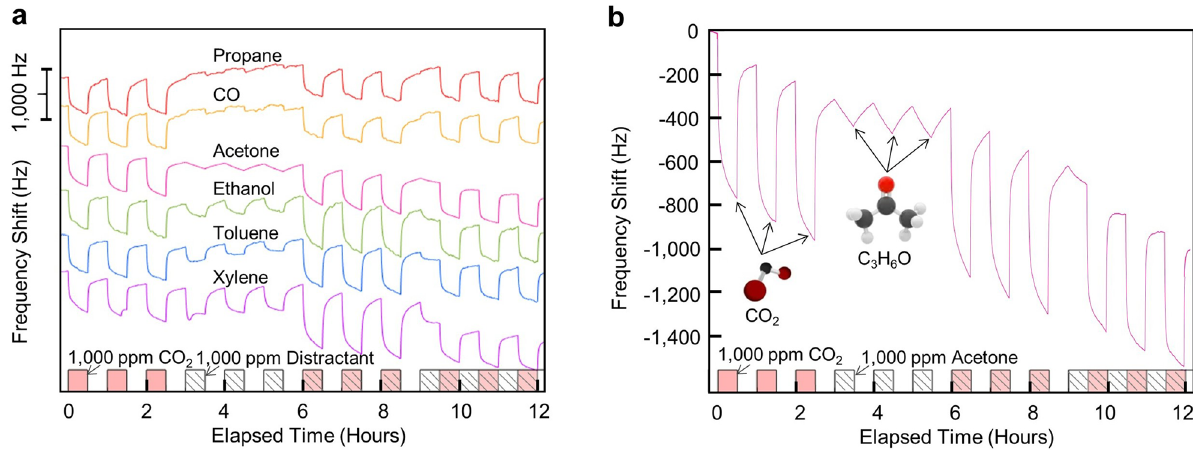
Figure 3. Sensor response to 1000 ppm pulses of CO 2 and various distractants. ( a ) Frequency shift responses of a sensor in the presence of various interfering gas analytes. ( b ) Zoomed frequency shift response of a sensor in response to CO 2 in the presence of acetone. The time series data shows 30 min pulses of CO 2 with a background of nitrogen, followed by pulses of acetone, pulses of CO 2 and acetone together, and finally pulses of CO 2 with a constant background of